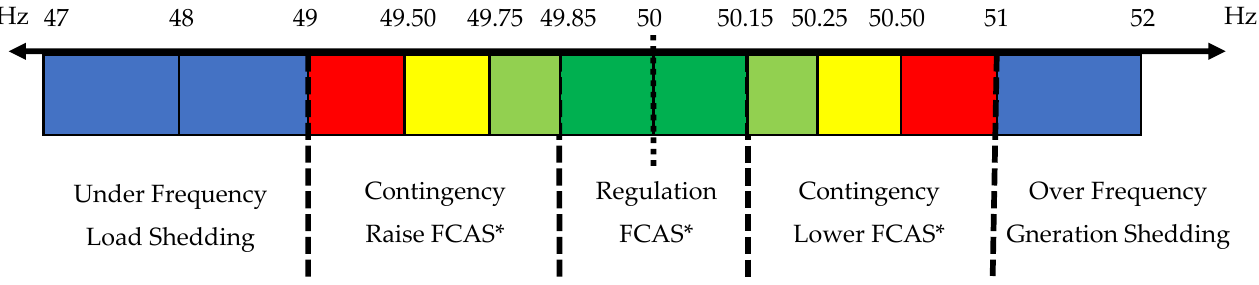
Figure 1. Typical power–frequency droop characteristic.